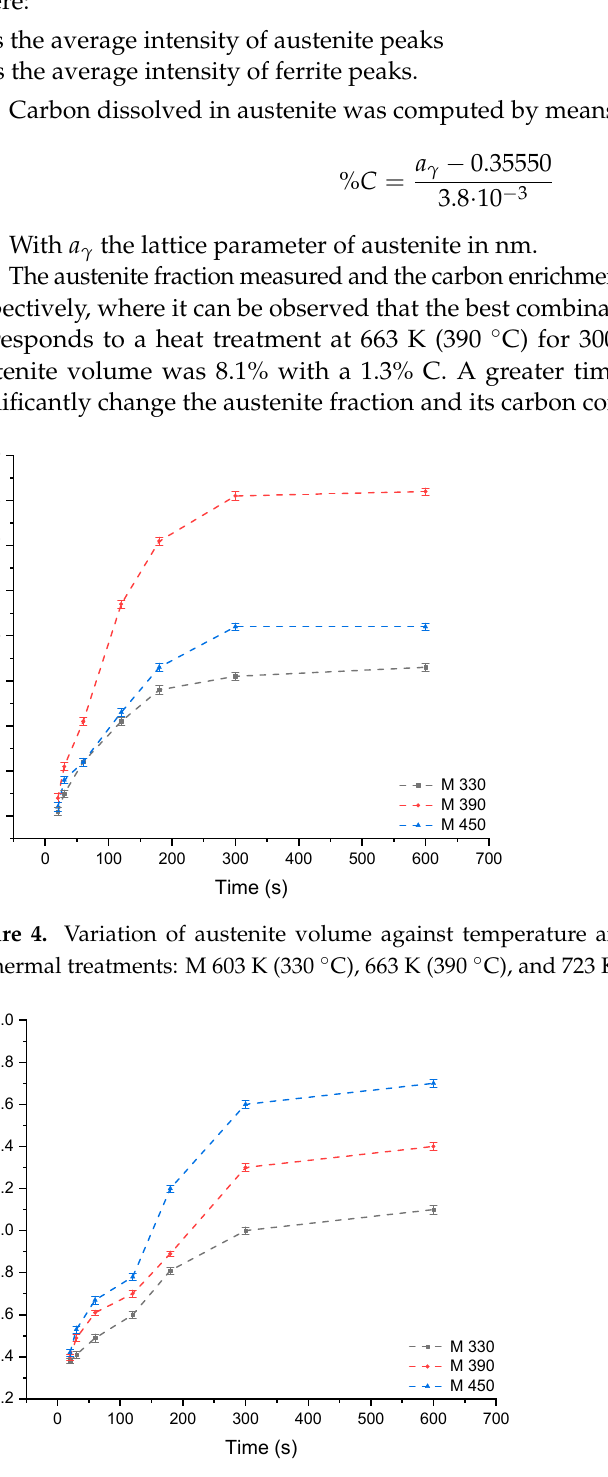
Figure 5. Variation of the carbon enrichment of austenite against temperature and soaking time during bainitic isothermal treatments: 603 K (330 °C), 663 K (390 °C), and 723 K (450 °C).